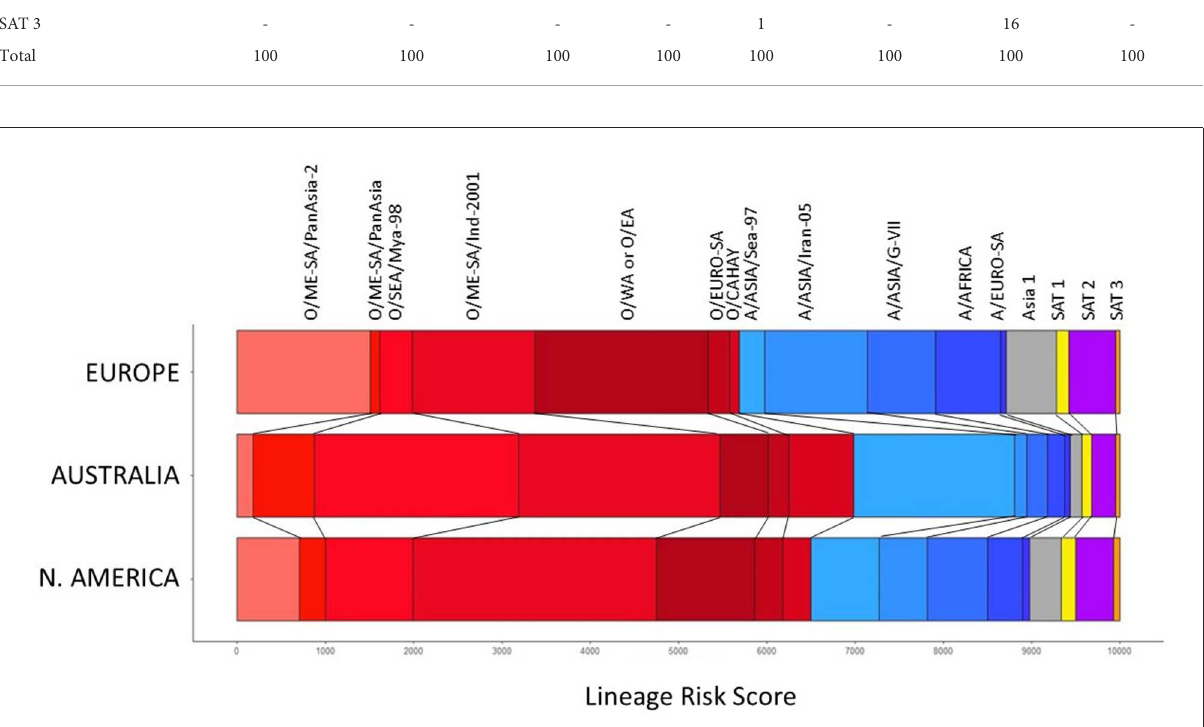
FIGURE1 Total lineage risk scores per serotype/topotype/lineage for each vaccine bank